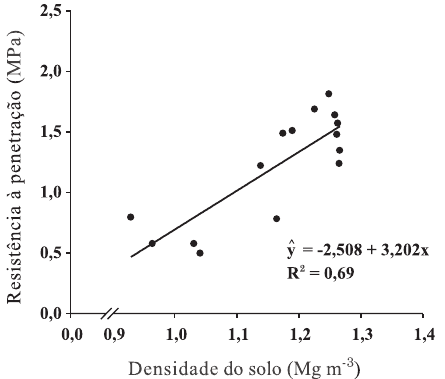
Figura 6. relação entre densidade do solo e resistência mecânica do solo à penetração (rp) de um latossolo Vermelho sob sistemas de culturas em plantio direto, considerando as camadas de 0–5, 5–10 e 10–20 cm. para adequar os dados de rp nas camadas analisadas, foi